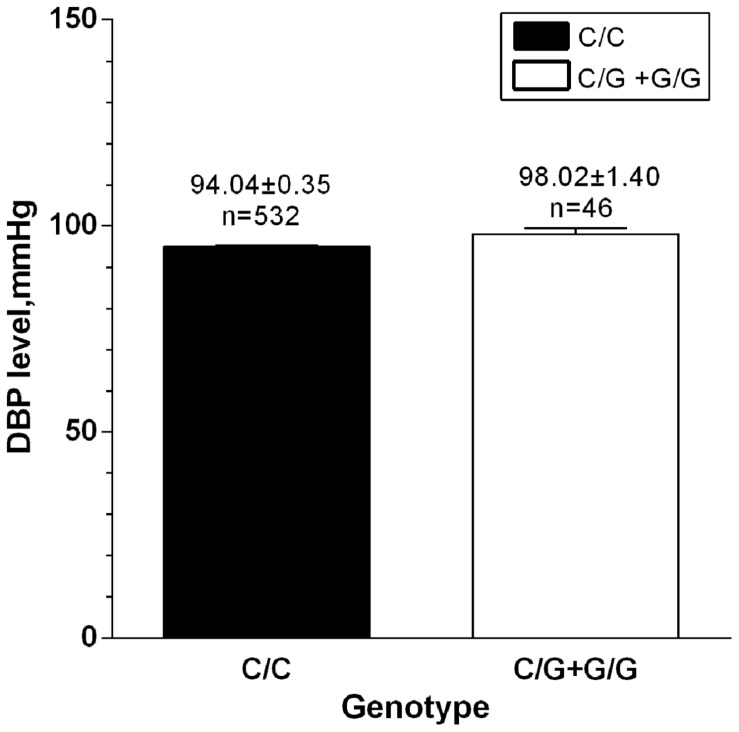
DBP level between G-carriers and wild type in those whose DBP ≥ 90 mmHg.
n = 578, p = 0.021.